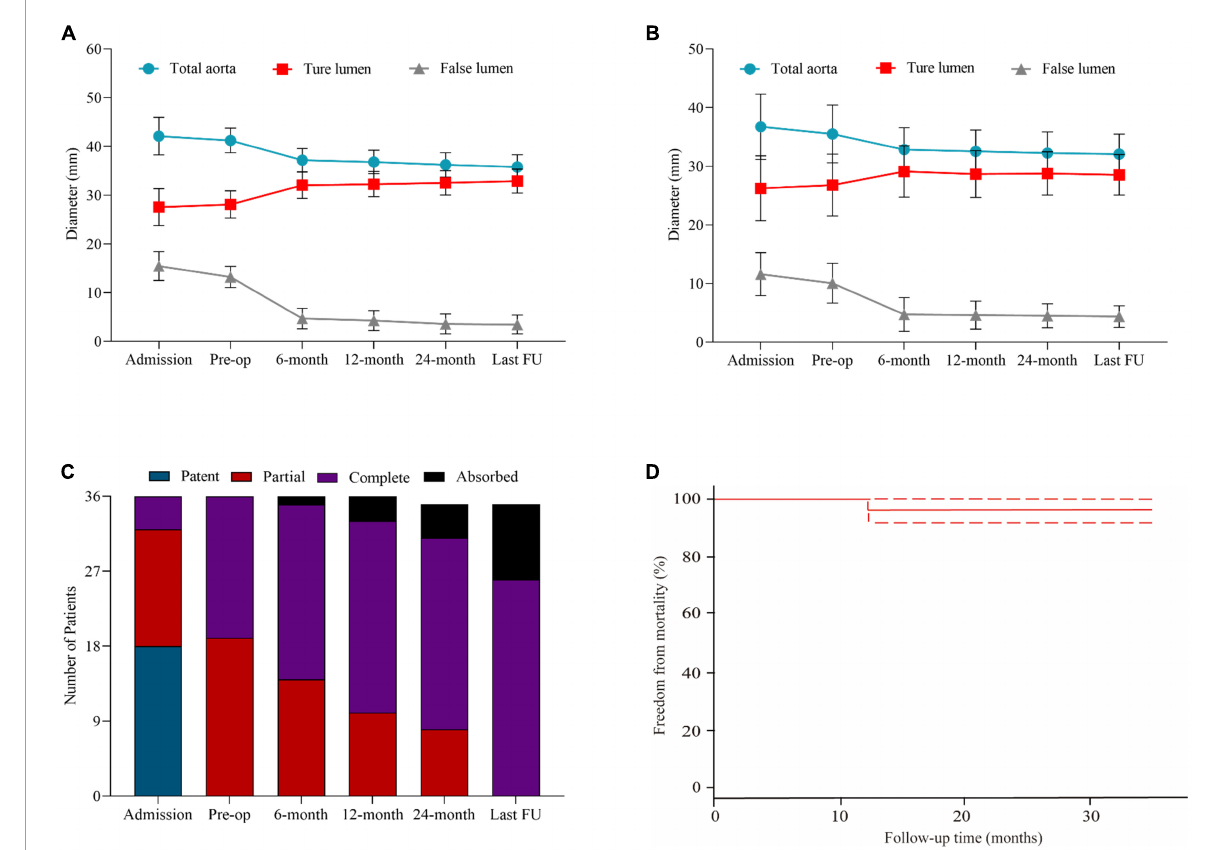
FIGURE3 Statistical analysis of aortic remodeling and survival probability during follow-up. (A) The changes of diameters of the total aorta, true lumen, and false lumen in the ascending aorta in patients at admission, before the operation, at 6, 12, 24 months, and the latest follow-up. (B) The changes of diameters of the total aorta, TL, and FL in the descending aorta in patients at admission, before the operation, at 6, 12, 24 months, and the latest follow-up. (C) The status of thrombosed proximal FL in patients in the ascending aorta at admission, before the operation, at 6, 12, 24 months, and the latest follow-up. (D) The probability of free from morality during follow-up every 3 months in all